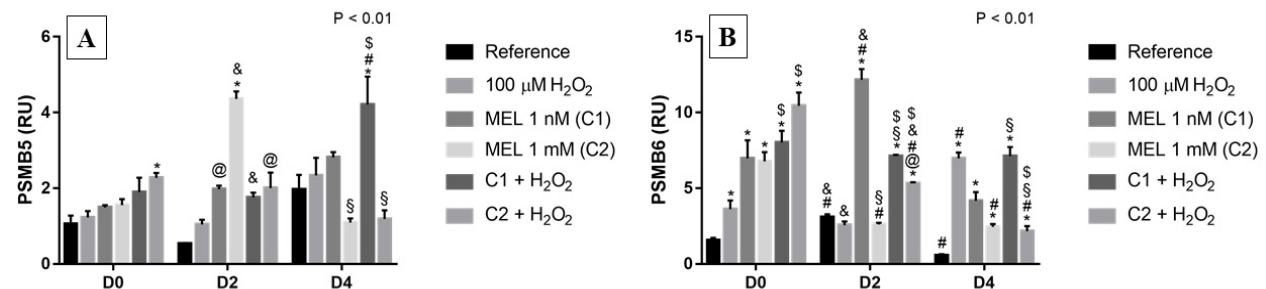
Figure 6. Relative expression of proteasome subunits PSMB5 and PSMB6 in K562 erythroid cells: ( A ) PSMB5 gene expression and ( B ) PSMB6 gene expression. Reference: K562 cells without induction of oxidative stress and not treated with melatonin; 100 µ M H 2 O 2 : Cells under stress induction with hydrogen peroxide; C1: cells treated with 1 nM melatonin; C2: cells treated with 1 mM melatonin; C1 + 100 µ M H 2 O 2 and C2 + 100 µ M H 2 O 2 : sets of cells treated with the same melatonin concentrations associated with stress induction; D0: before the differentiation, D2: beginning of cell differentiation; D4: maximum of the differentiation process. * Effects of treatments within each period compared to the respective reference groups; # Effect of the incubation period within each treatment compared to their counterparts in D0; & Effect of the incubation period between D2 and D4